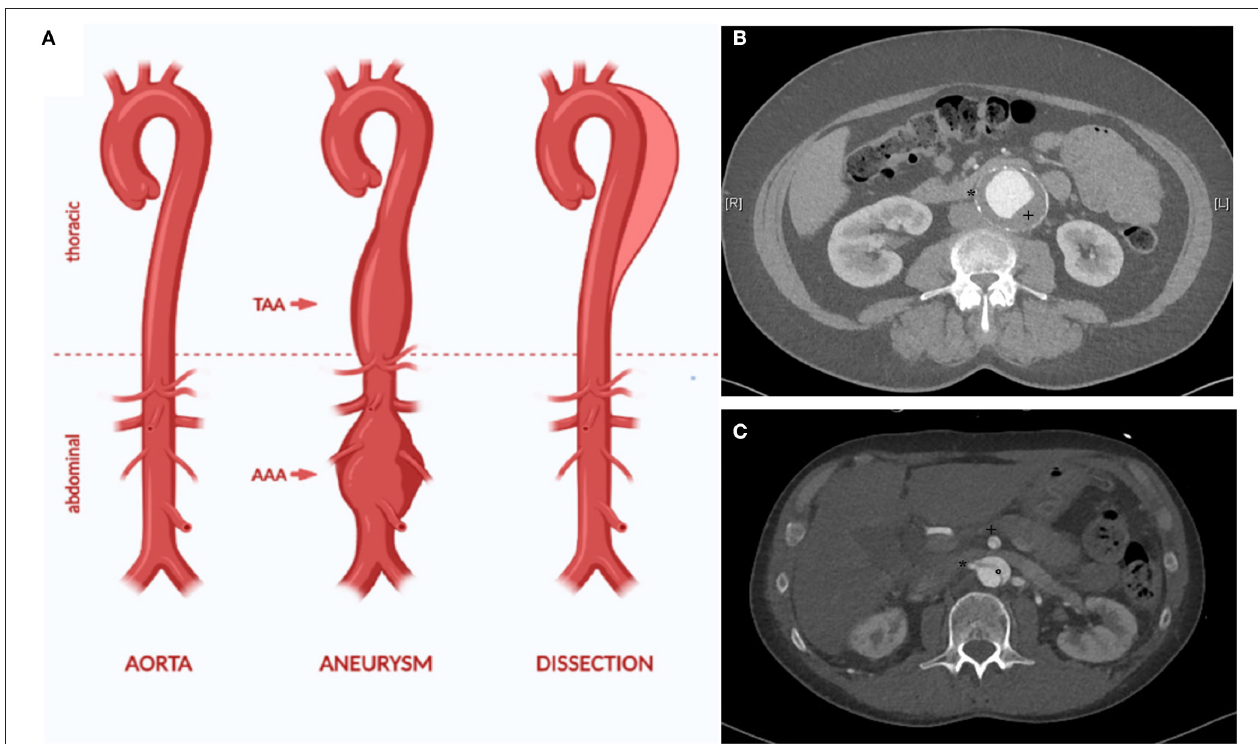
FIGURE 1 | The aorta can be affected by different disease, for example aortic aneurysm and dissection (A) . AA is defined as dilatation of all layers of the vessel wall (true aneurysm). This can affect all parts of the aorta, for example the thoracic and the abdominal aorta (thoarcic aortic aneurysm (TAA) and abdominal aortic aneurysm (AAA). The CT angiography depicts characteristic traits of an infrarenal aneurysm with thrombus ( + ) and calcification of the aortic wall (*) (B) . In AD, an initial intima lesion causes separation of the aorta in a true and false lumen by a dissection membrane ( ◦ ) (C) . Visceral arteries such as the superior mesenteric artery ( + ) and the right renal artery (*) can be affected by the dissection causing organ ischemia. Due to the reduced stability of the aortic wall, most patients with AD require surgical treatment in the long term due to chronic dilatation of the aorta [modified from (